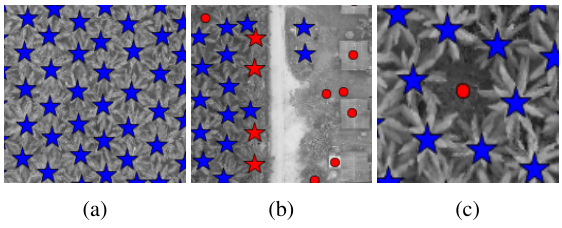
Figure 14: (a) Detection in high cultivation density. False detec- tions on (b) artificial objects and, (c) false star-shape. [Blue-star: Detection, Red-star: Missed, Red-dot: False detection] rately the system localizes center is made by calculating the root mean square of the deviations of true detections from object cen- ters as discussed in Section 2.5.3. The localization error of CAPS in case of δ =40px is less than 20px and 70px for allowed δ = 100px. The maximum localization error occurs for Image 08, for which accuracy of detection is also worst. Except image 08 for δ =100px, all other images have localization accuracy below 50px, which is half of the allowed error. Furthermore, during the feature map derivation, the shift along rows and columns are carried out in an interval of 5 pixels, which also contribute signifi- cantly to the degradation of the locational accuracy of detections.